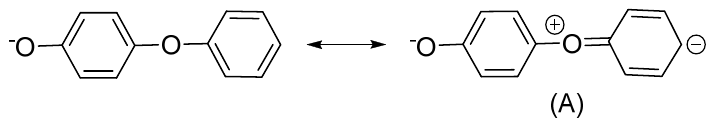
Figure 8. FTIR spectra of sodium p -cresolate (soluble part) with temperature.